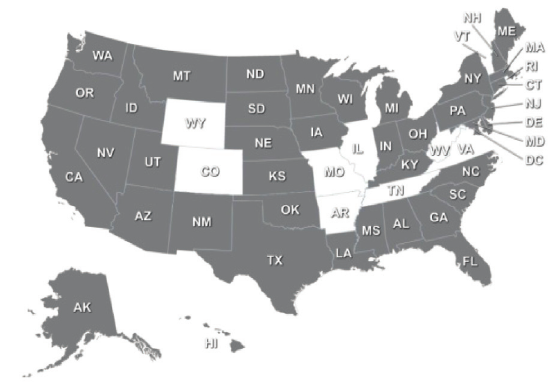
Fig. 2. Map of states surveyed